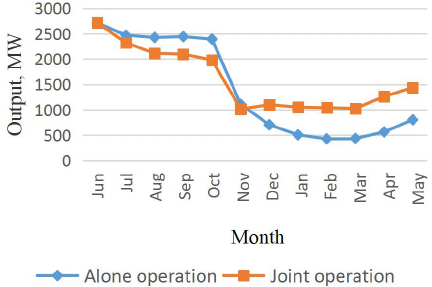
Figure 3. The output of plant A.